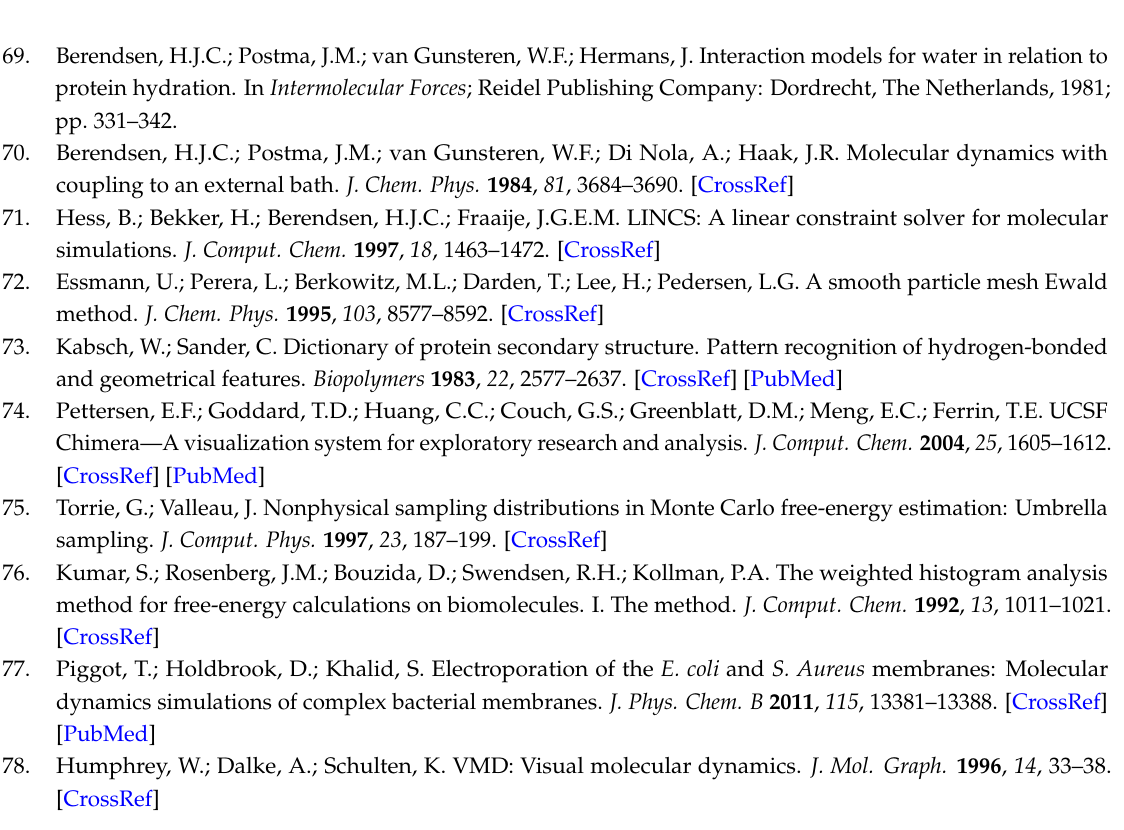
Sample Availability: The files used to simulate the investigated peptides with the GROMACS software package are available from the